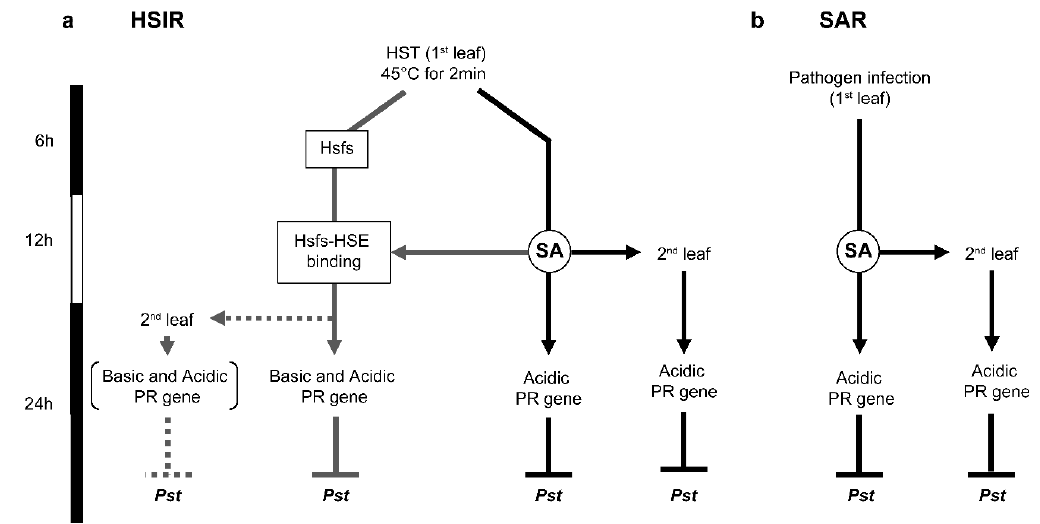
Figure 12. Comparison between HSIR ( a ) and systemic acquired resistance (SAR) ( b ). Black lines indicate proved pathways and gray lines indicate proposed pathways as elucidated by the work reported herein. During HSIR, Heat shock induced Hsfs gene expression, followed by SA accumulation, which in turn enhanced Hsfs binding to HSE, thereby activating non-systemic stimulation of basic and acidic PR gene expression. Disease severity in the first leaf was significantly reduced concomitantly with upregulation of PR gene expression when Pst was inoculated.